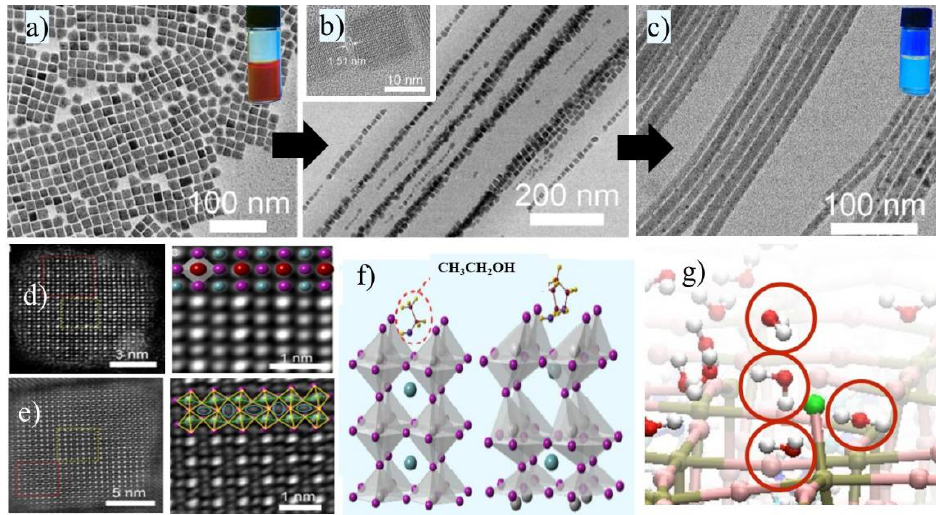
Figure 3. ( a – c ) TEM images showing the transformation of α -CsPbI 3 nanocubes to δ -CsPbI 3 nanowires during the reaction of α -CsPbI 3 nanocubes with ethanol, insets show their respective photographs of nanocrystal solutions collected under UV light; ( d , e ) STEM images of α -CsPbI 3 NCs and δ -CsPbI 3 NCs; ( f ) Simulated model of ethanol molecules adsorbed on α -CsPbI 3 NCs structure causing the structural distortion. The images ( a – f ) adapted with permission from Ref. [67]; Copyright 2018 American Chemical Society. ( g ) Simulated model shows a view of three H 2 O molecules lifting an iodide atom (depicted in green for clarity). Adapted with permission from Ref. [68]. Copyright 2017 American Chemical Society.